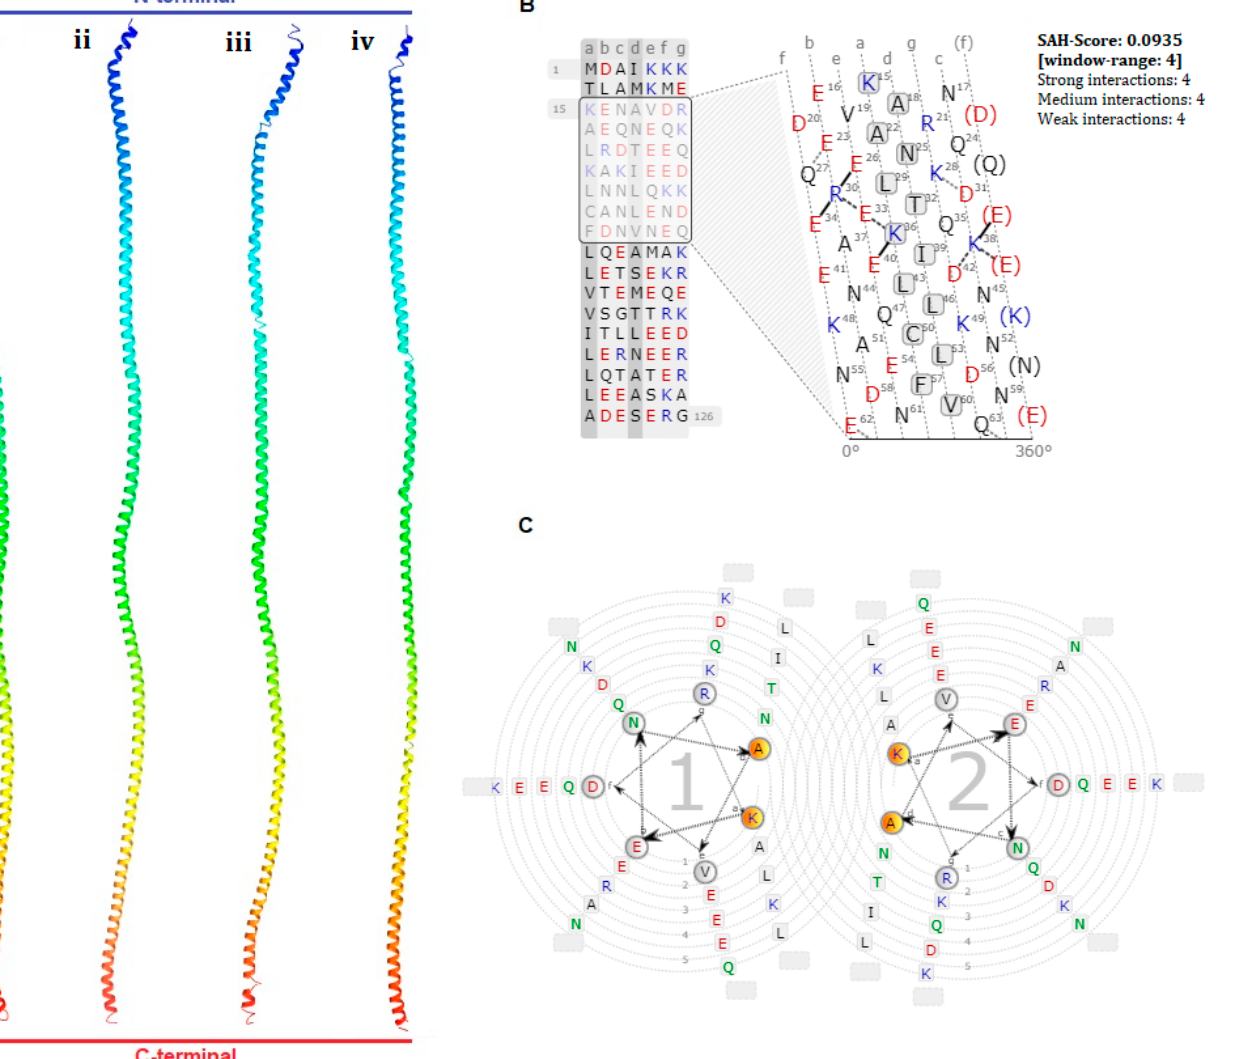
Figure 4. ( A ) Three-dimensional structure prediction of amino acid sequence from four abalone species (i) H. discus hannai , (ii), H. asisina , (iii) H. discus discus and (iv) H. rufescens . ( B ) A single α helical (SAH) interaction in the protein heptad net view. ( C ) A coiled-coil wheel view of the Hdh-TPM protein.